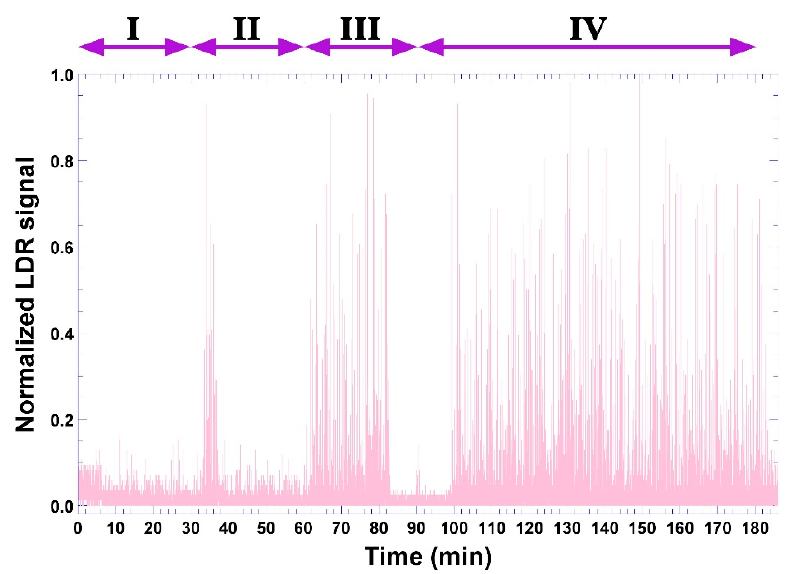
Figure 12. Evolution of the normalized LDR (Light-Dependent Resistor) signal throughout the bioreaction timeframe, using the bioluminescent hydrogel in bio-detection system II.